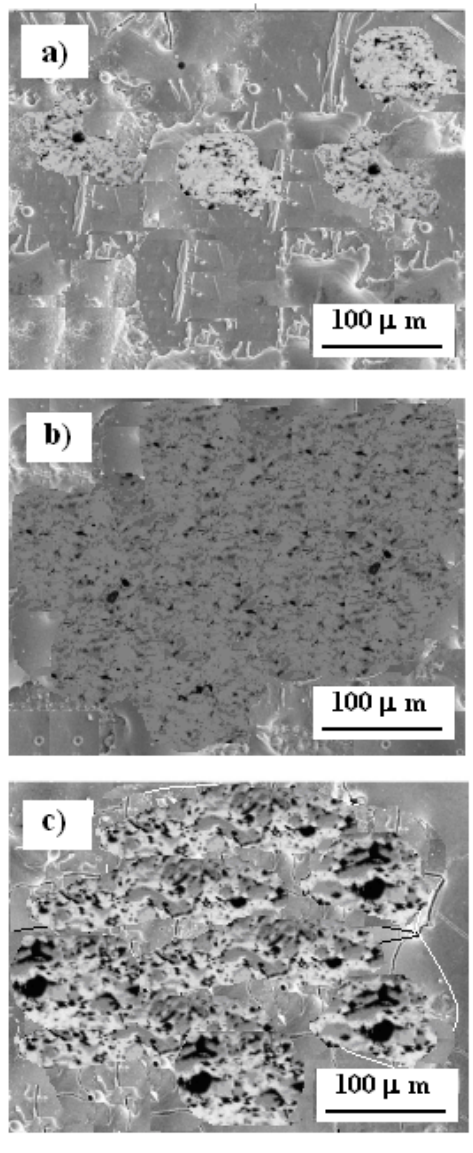
Figure 11. Photograph images of the Al/Cu surface: ( a ) before and after heat treatment at: ( b ) 400 °C or ( c ) 600 °C in air atmosphere and after the corrosion test in 1.2 M Cl − , pH 1.5. Exposure time was five hours.